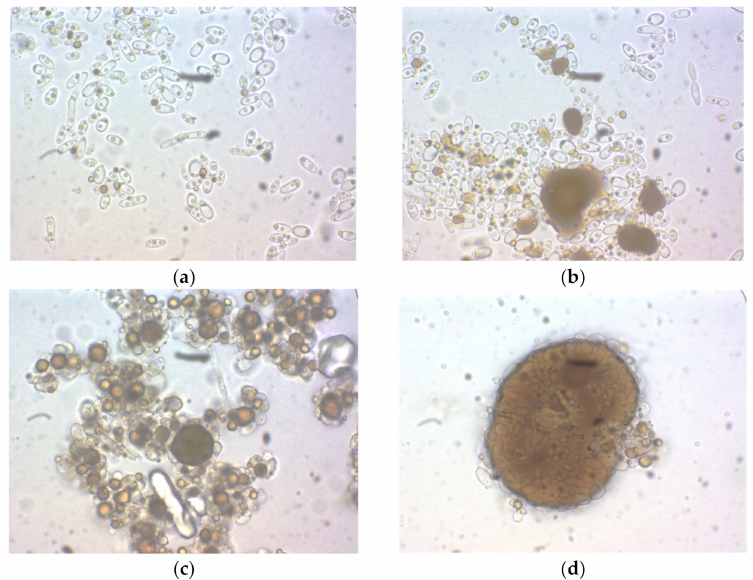
Figure 10. Optical microscopic observations of the culture medium after 96 h of Y. lipolytica IMUFRJ 50682 cultivation in medium with 2% glucose and 1% v / v oil ( a , b ) and in medium with 1% v / v oil ( c , d